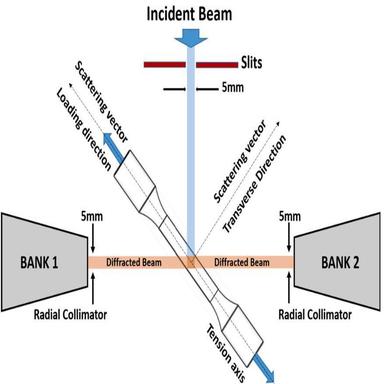
Schematic drawing of experimental set-up on beamline-7 Vulcan at SNS.